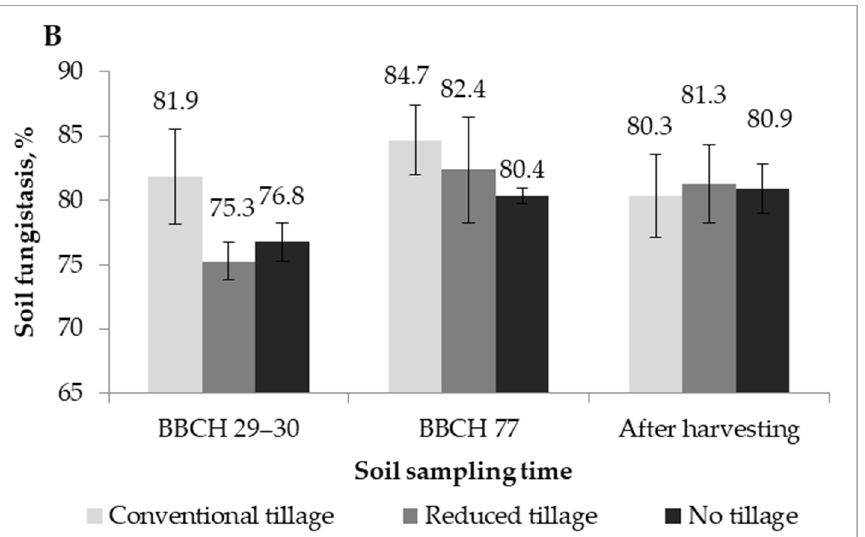
Figure 3. Soil fungistasis (%) against F. graminearum growth depending on the different tillage practices and soil sampling times in ( A ) 2016 and ( B ) 2017. BBCH 31–33—renewal of the plant vegetation (19 May 2016 and 21 April 2017); BBCH 69—the end of the winter wheat flowering (13 June 2016); BBCH 77—the development of oilseed rape fruit (19 June 2017) and after harvesting (27 July 2016 and 29 August 2017). * Indicates a significant difference between the treatments at a confidence level of 0.95. The error bars indicate the standard deviations within the biological replications at each treatment.